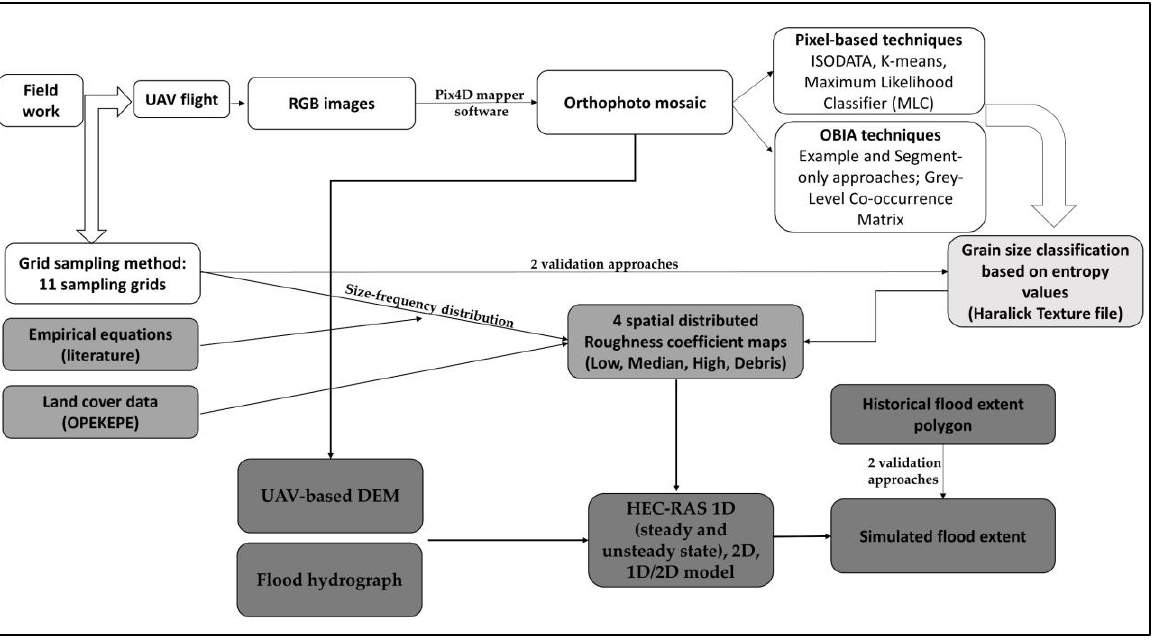
Figure 1. Flowchart of research methodology steps. Different shades of grey color represent the distinct methodological approaches (the three grey shades ranging from light to dark grey represent the grain size classification based on entropy values, the generation of the spatially distributed roughness coefficient maps, and the estimation of the flood extent,